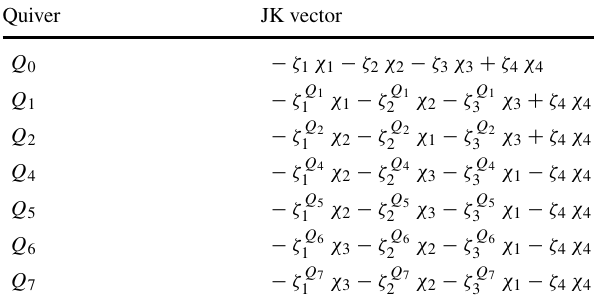
Table 4 For each quiver we list the JK reference vector that picks the appropriate contour on the localization side. The parameter ζ 4 is always positive and bigger in magnitude than any of the FI parameters. If ζ Q i I